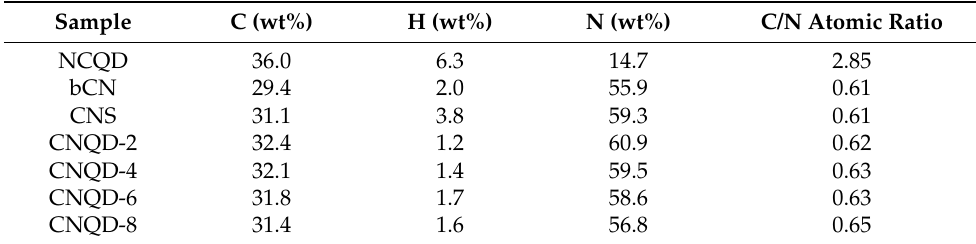
Table 1. Elemental analyses (C, H, and N) of bCN, CNS, NCQD, and CNQD